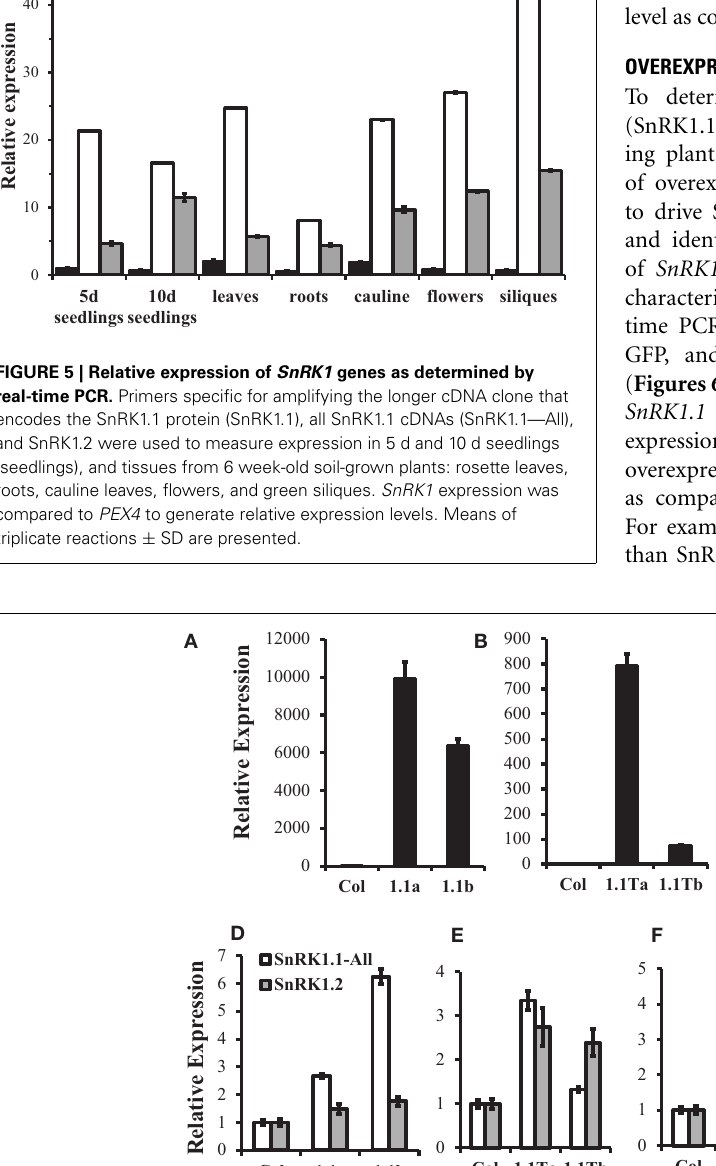
lines with RNA extracted from (D–F) rosette leaves of 60d soil-grown plants, and (G) 10d seedlings. Means of triplicate reactions ± SD are presented. Two or more biological replicates were performed for